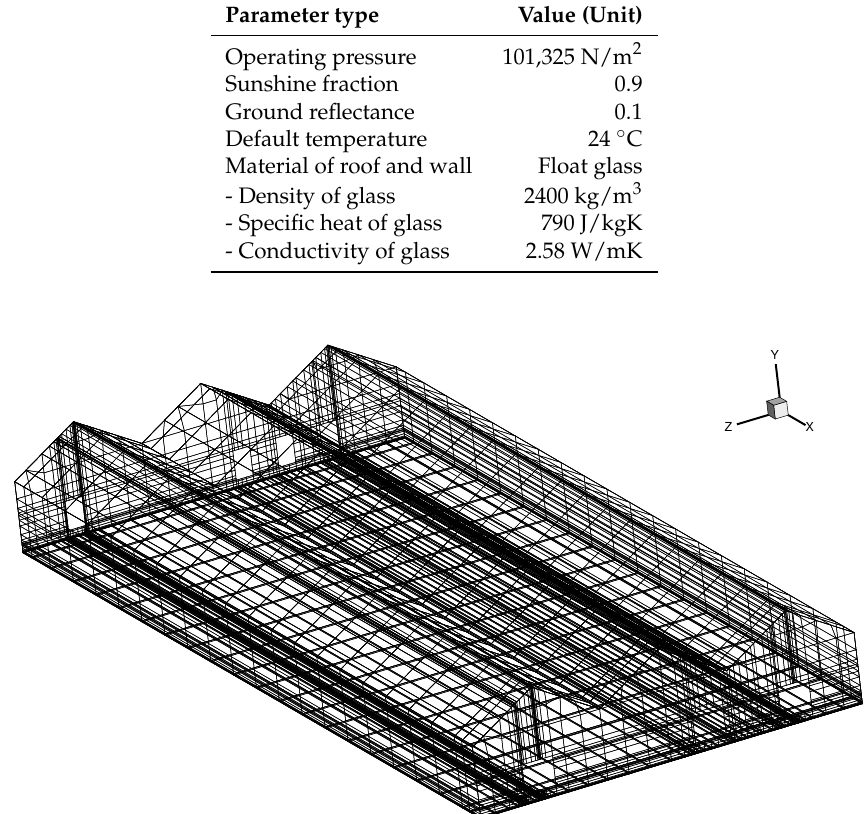
Figure 4. The structure of the greenhouse model with